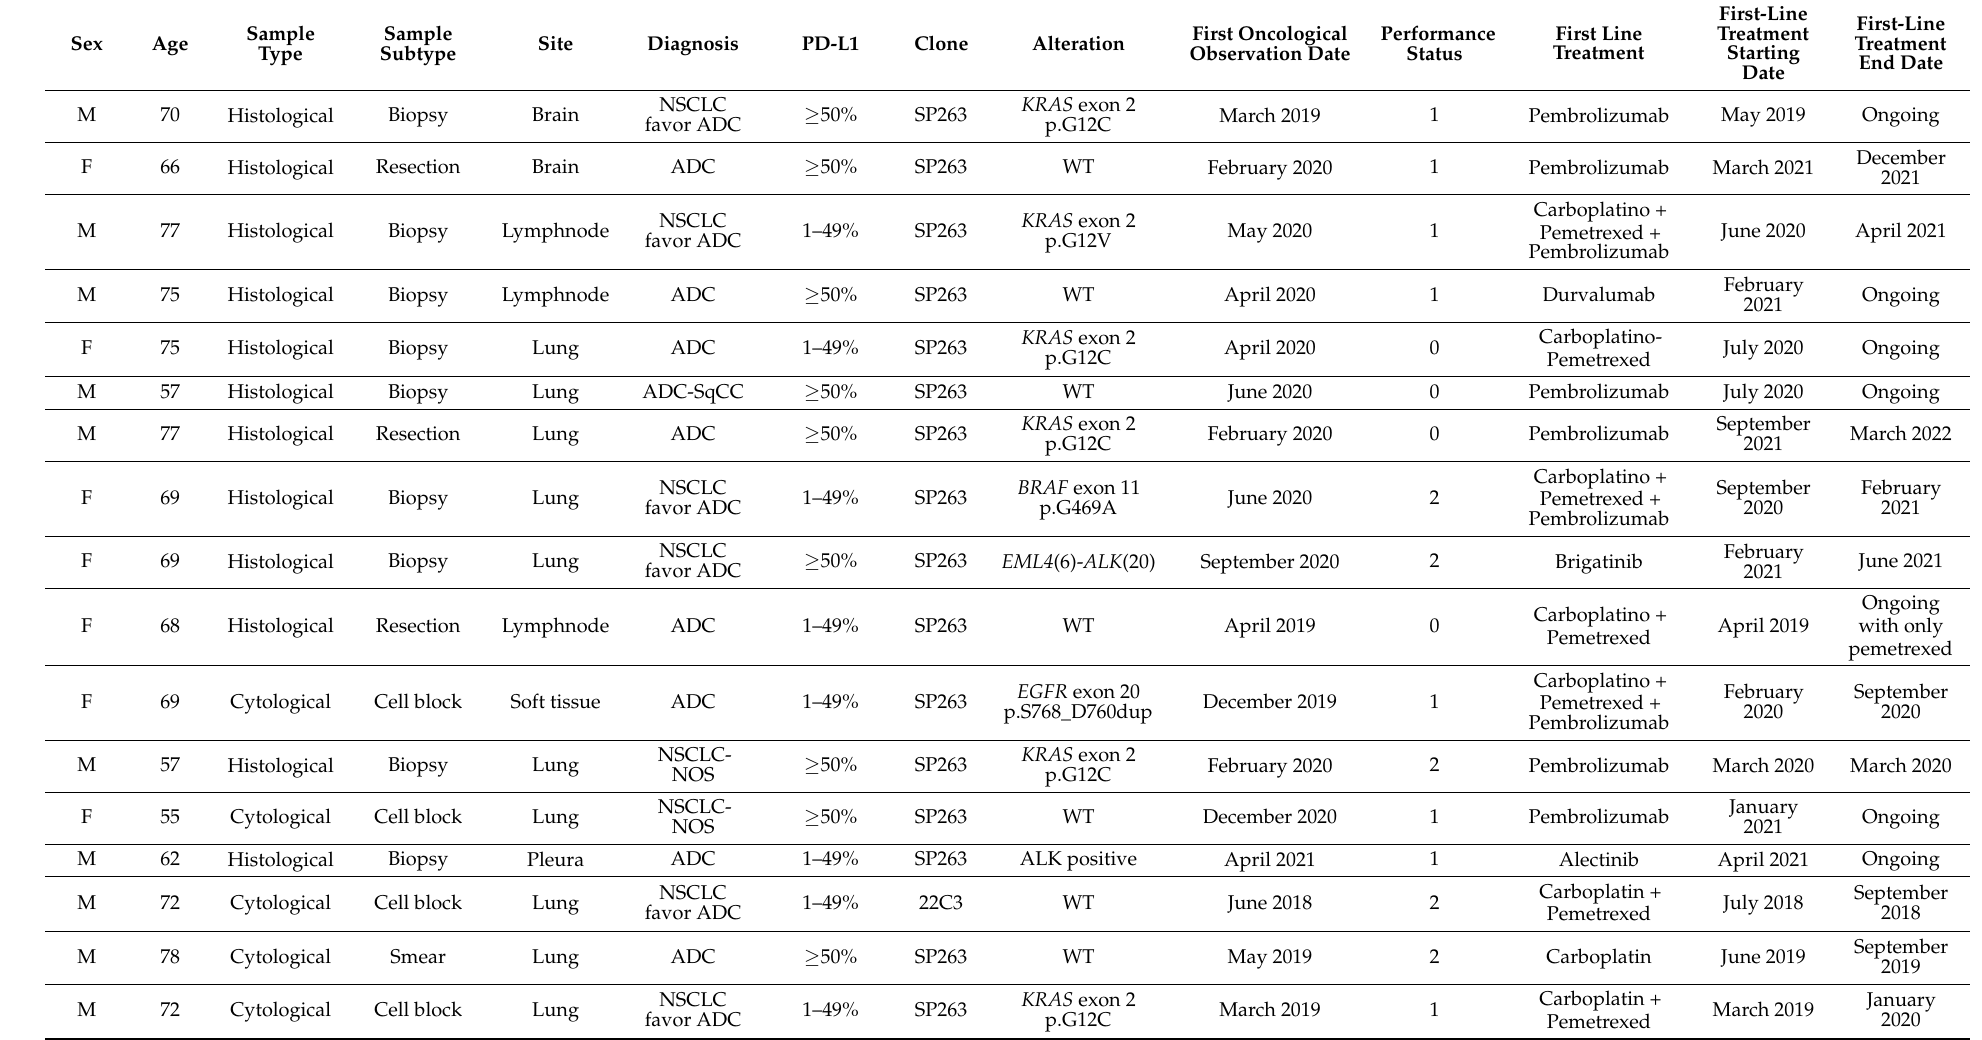
Table 2. Clinical